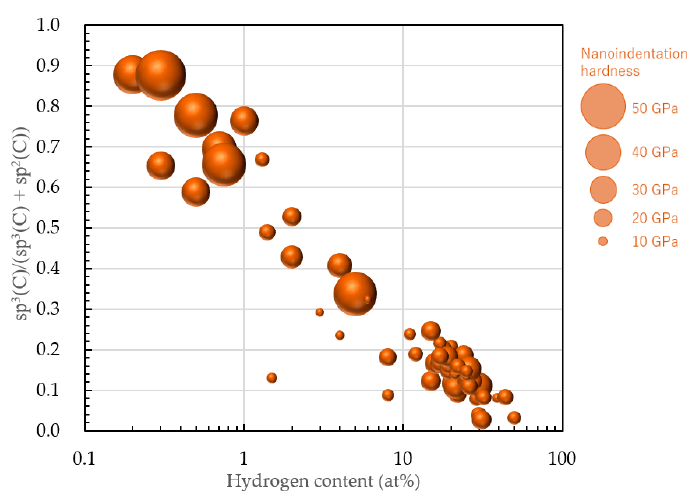
Figure 12. Distribution of 74 types of amorphous carbon films on the sp3(C) ratio–logarithmic hydrogen content plane after modifying the sp3 ratio derived by NEXAFS. Diameter of circle corresponds to the nanoindentation hardness of each amorphous carbon film.